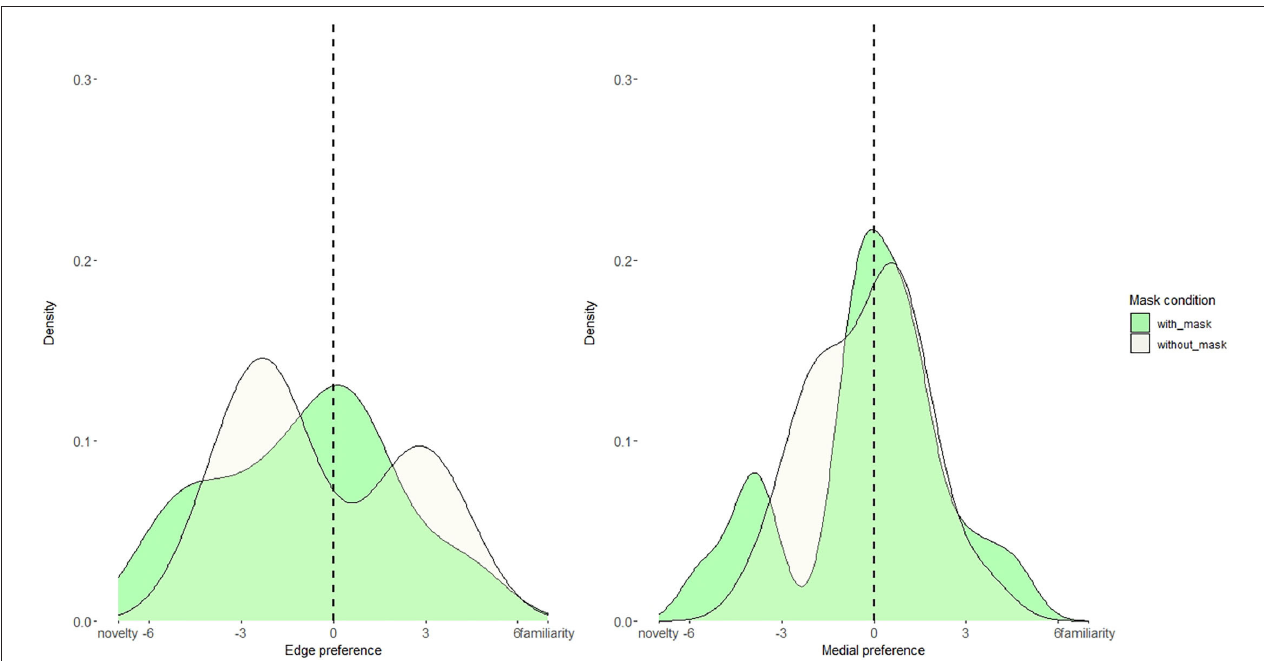
FIGURE 9 | Density distribution plots for edge and medial looking preferences in with-mask (green) and without-mask (beige)